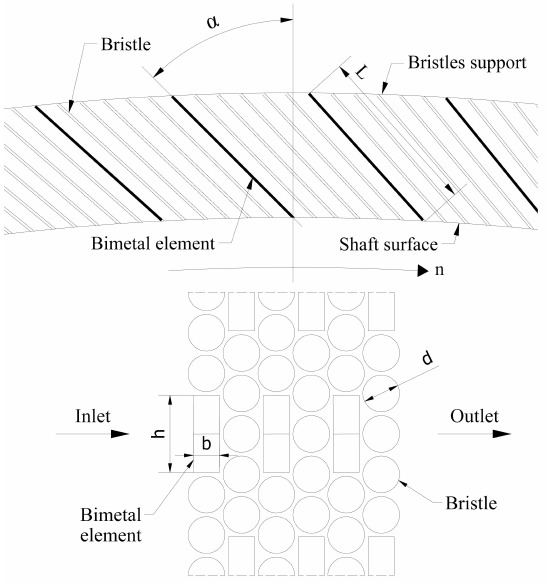
Figure 1: Scheme of the brush seal with bimetal